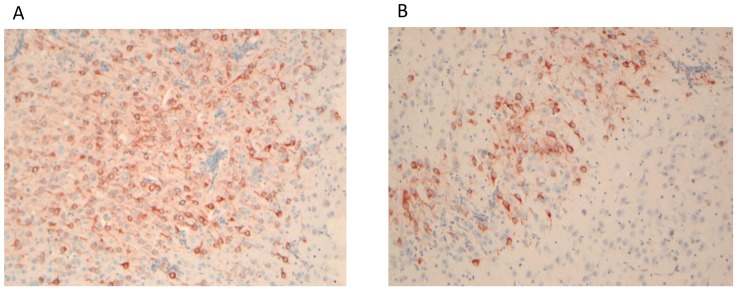
Viral antigen in the brains of CHIKV infected mice.A: CHIKV-antigen present in the cortex of CHIKV-infected mice two days post infection (objective 10x). B: CHIKV-antigen present in the thalamus of infected mice three days post infection (objective 10x).